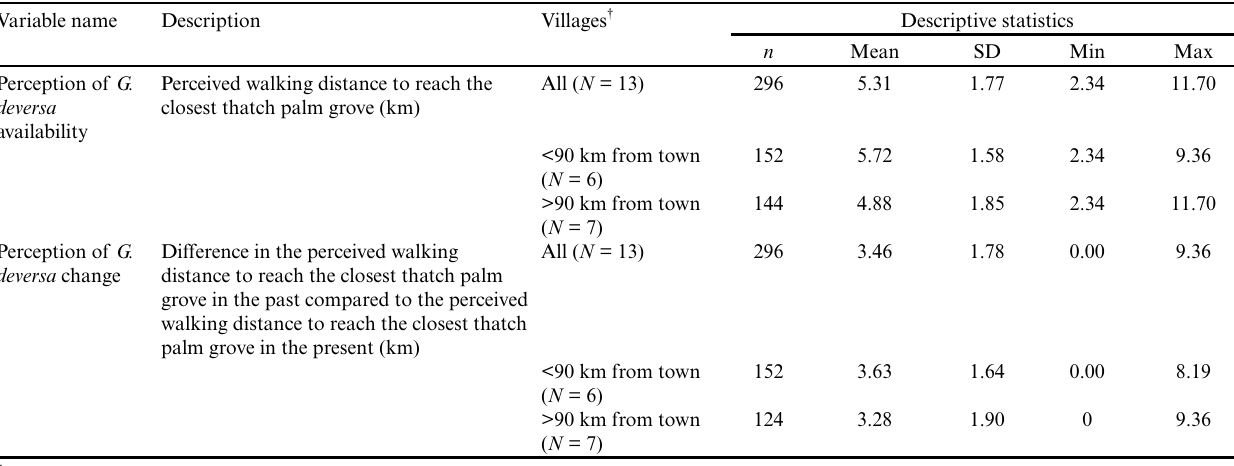
Table 2 . Definition and summary statistics of variables measuring perception of Geonoma deversa change and availability among Tsimane' interviewees.